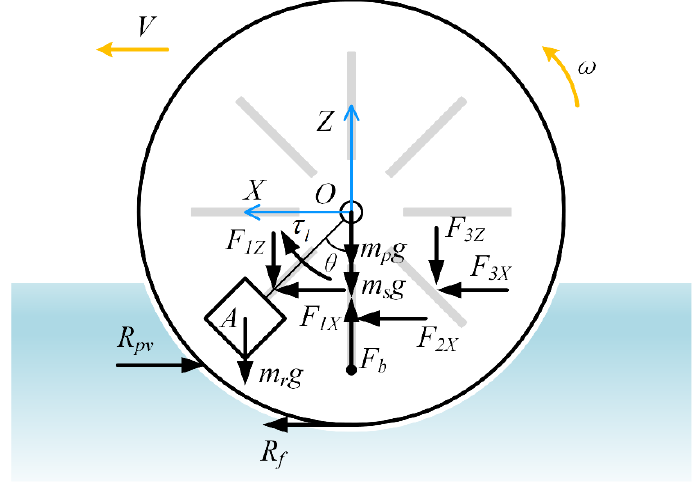
Figure 6. Force analysis of the amphibious spherical robot.